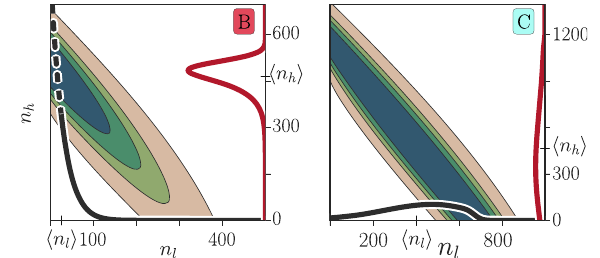
FIG. 6. Two-mode photon statistics obtained from the reduced master equation for the same parameters as in Fig. 4, B and C, but with spontaneous transitions fully included between the modes. In contrast to the case with suppressed spontaneous transitions, the statistics are no longer attracted to the axis. The color bar is the same as in Fig. 4. For a better comparison, the single-mode statistics are depicted up to 0.015% by solid lines, while the remaining part is shown by dashed